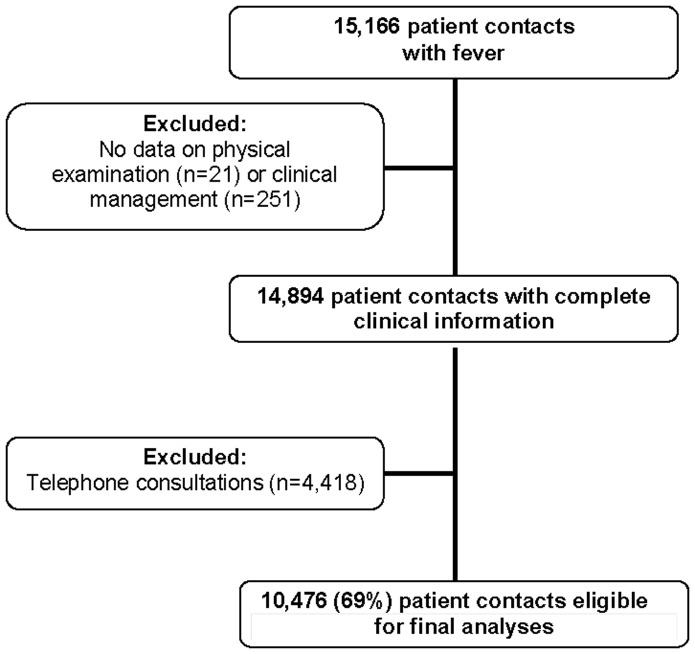
Selection of eligible contacts for the study.